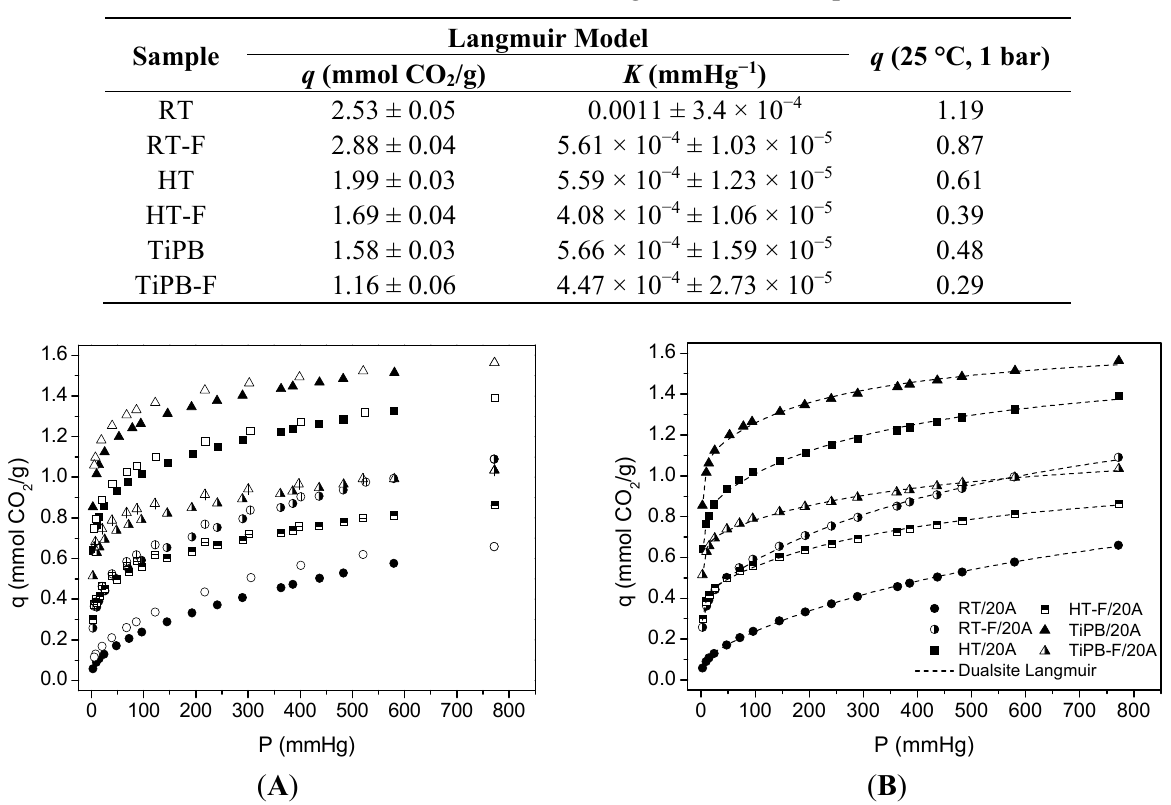
Figure 4. ( A ) CO 2 adsorption/desorption isotherms at 25 °C on pure silicas. Filled symbols stand for adsorption data and empty symbols stand for desorption data; dotted lines ( B ) are fits from the Langmuir model equation using adsorption data. Table 3. Parameters from fit to Langmuir model for pure silicas.